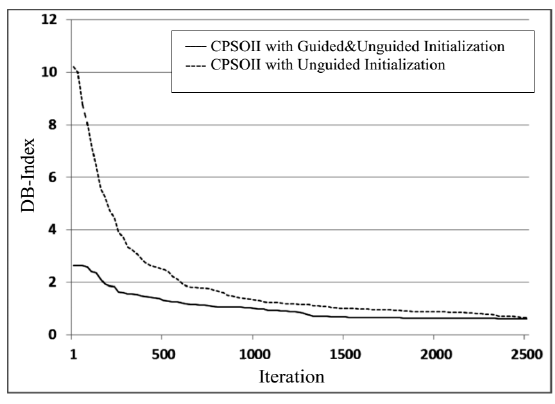
Figure 7. Comparing convergence of CPSOII with Guided & Unguided initialization toward qualified solutions (using DBI criterion) for a week STW feature